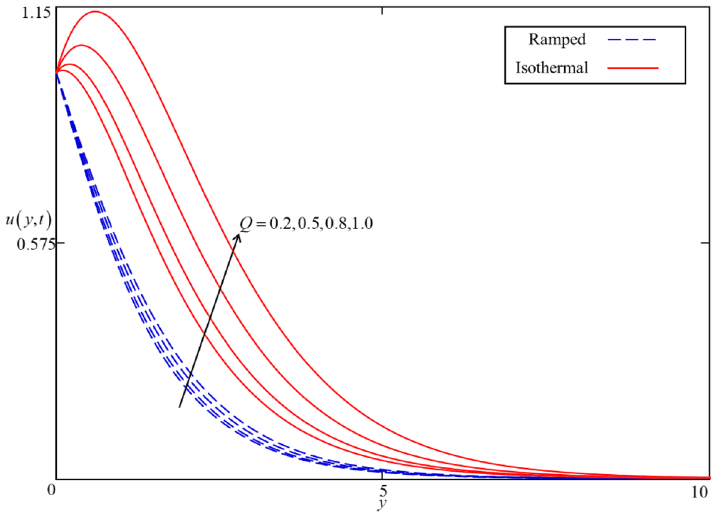
y , t when α = 0.5 , φ = 0.04 , β = 0.5 , M = 0.5 , Gr = 5 , Nr = 0.5 and (cid:30) (cid:31)